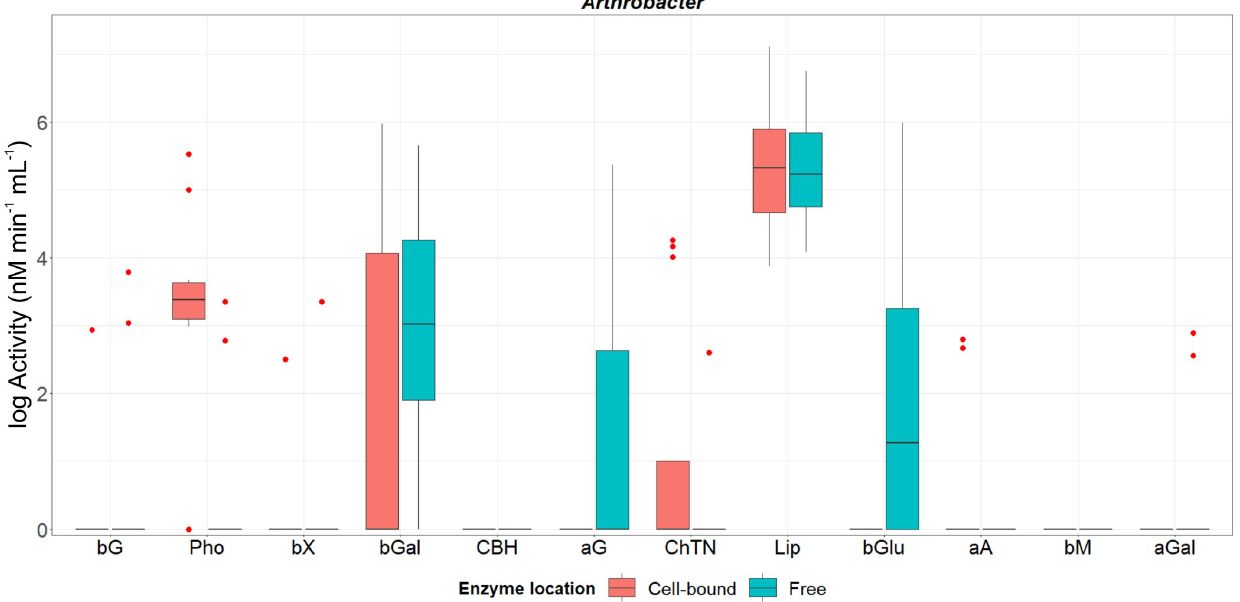
Fig 3. Activity of cell-associated and freely-released enzymes from genus Arthrobacter . Box and whiskers were represented in the style of Tukey. Hinges correspond to the 1 st and 3 th quartiles and medians of the activity of each enzyme recorded for all strains are represented by horizontal lines. Red points correspond to those data beyond 1.5 x Inter Quartile Range. No significant differences were detected between both fractions according to the non- parametric Mann-Whitney U test at a confidence level of 95%. Abbreviations of enzymes: bG: β -glucosidase; Pho: acid phosphatase; bX : β -xylosidase; bGal : β -galactosidase; CBH: cellobiohydrolase; aG : α -glucosidase; ChTN: chitinase; Lip: lipase; bGlu : β -glucuronidase; aA : α -arabinosidase; bM : β - mannosidase; aGal : α -galactosidase. All the data were log-transformed for graphical clarity by fitting the same scale.